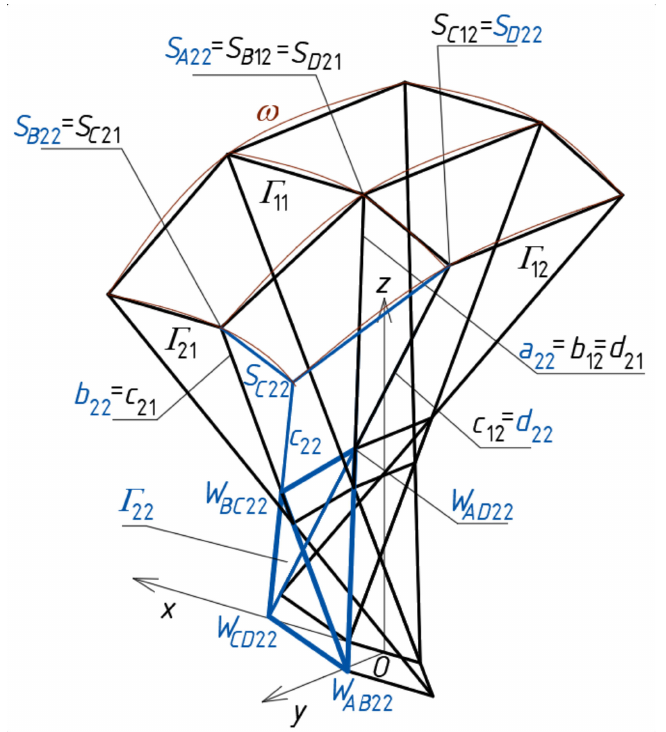
Figure 14. An auxiliary quadrilateral net determining a reference surface ω the polyhedral net Γ